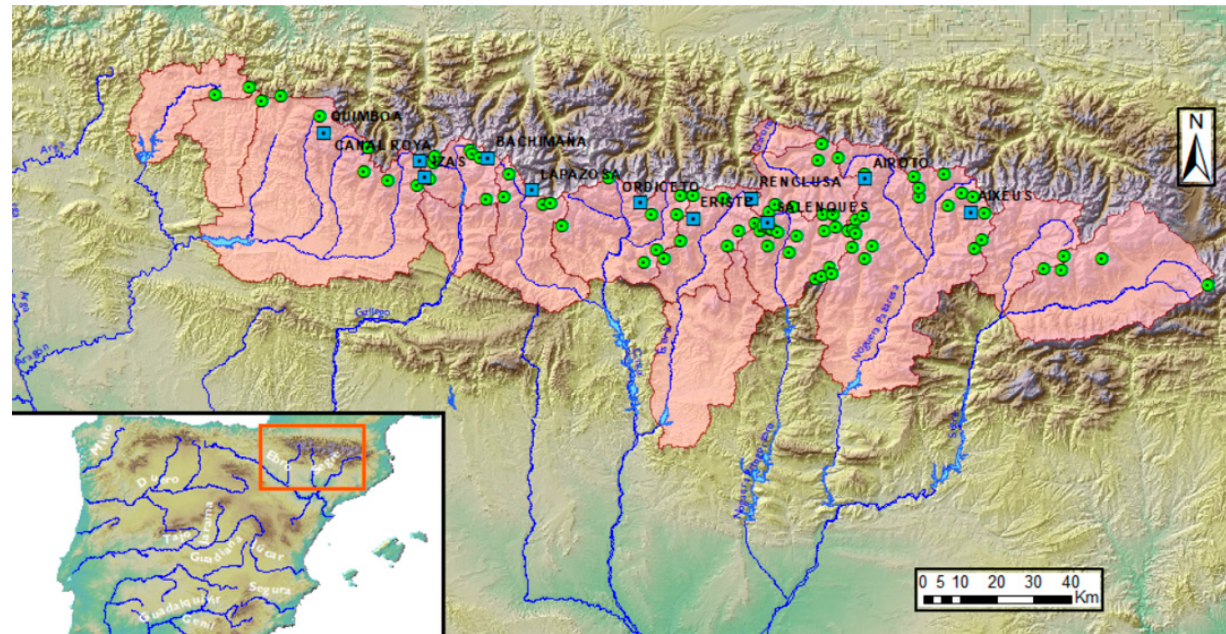
Figure 1. Snow poles (green) and telenivometers (TNM) (blue) network from the ERHIN program [44] in the Pyrenees.